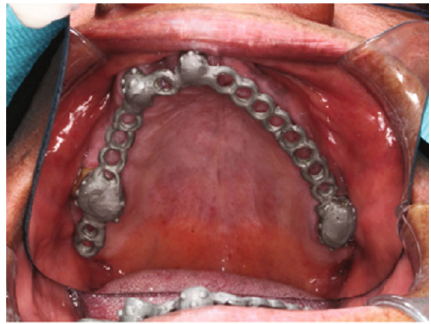
Figure 15: Impression for lower chrome cobalt framework.